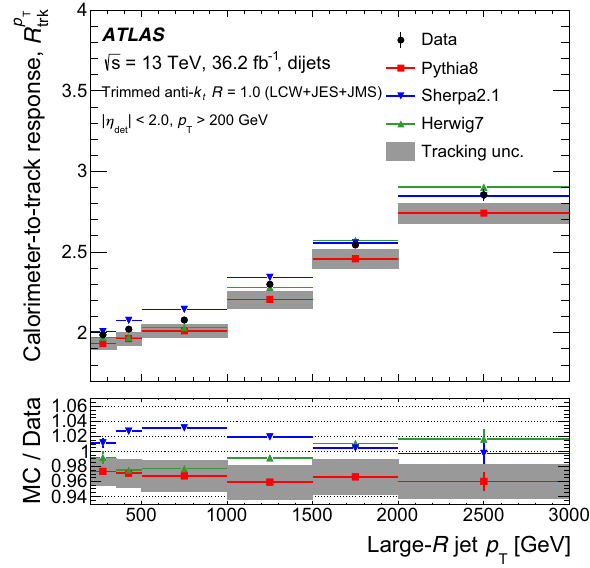
Fig. 14 Measurementof R p T asafunctionofthelarge- R jettransverse trk momentum p T for large- R jets with m / p T = 0 . 2. The large- R jet p T is corrected using the simulation calibration, η -intercalibration, and a combination of in situ direct balance techniques. Data are compared with three generators and with three tracking variations for the default generator Pythia 8 (shown as a band around these points). The double ratio of R p T measured in simulations and data is shown in the lower trk panel